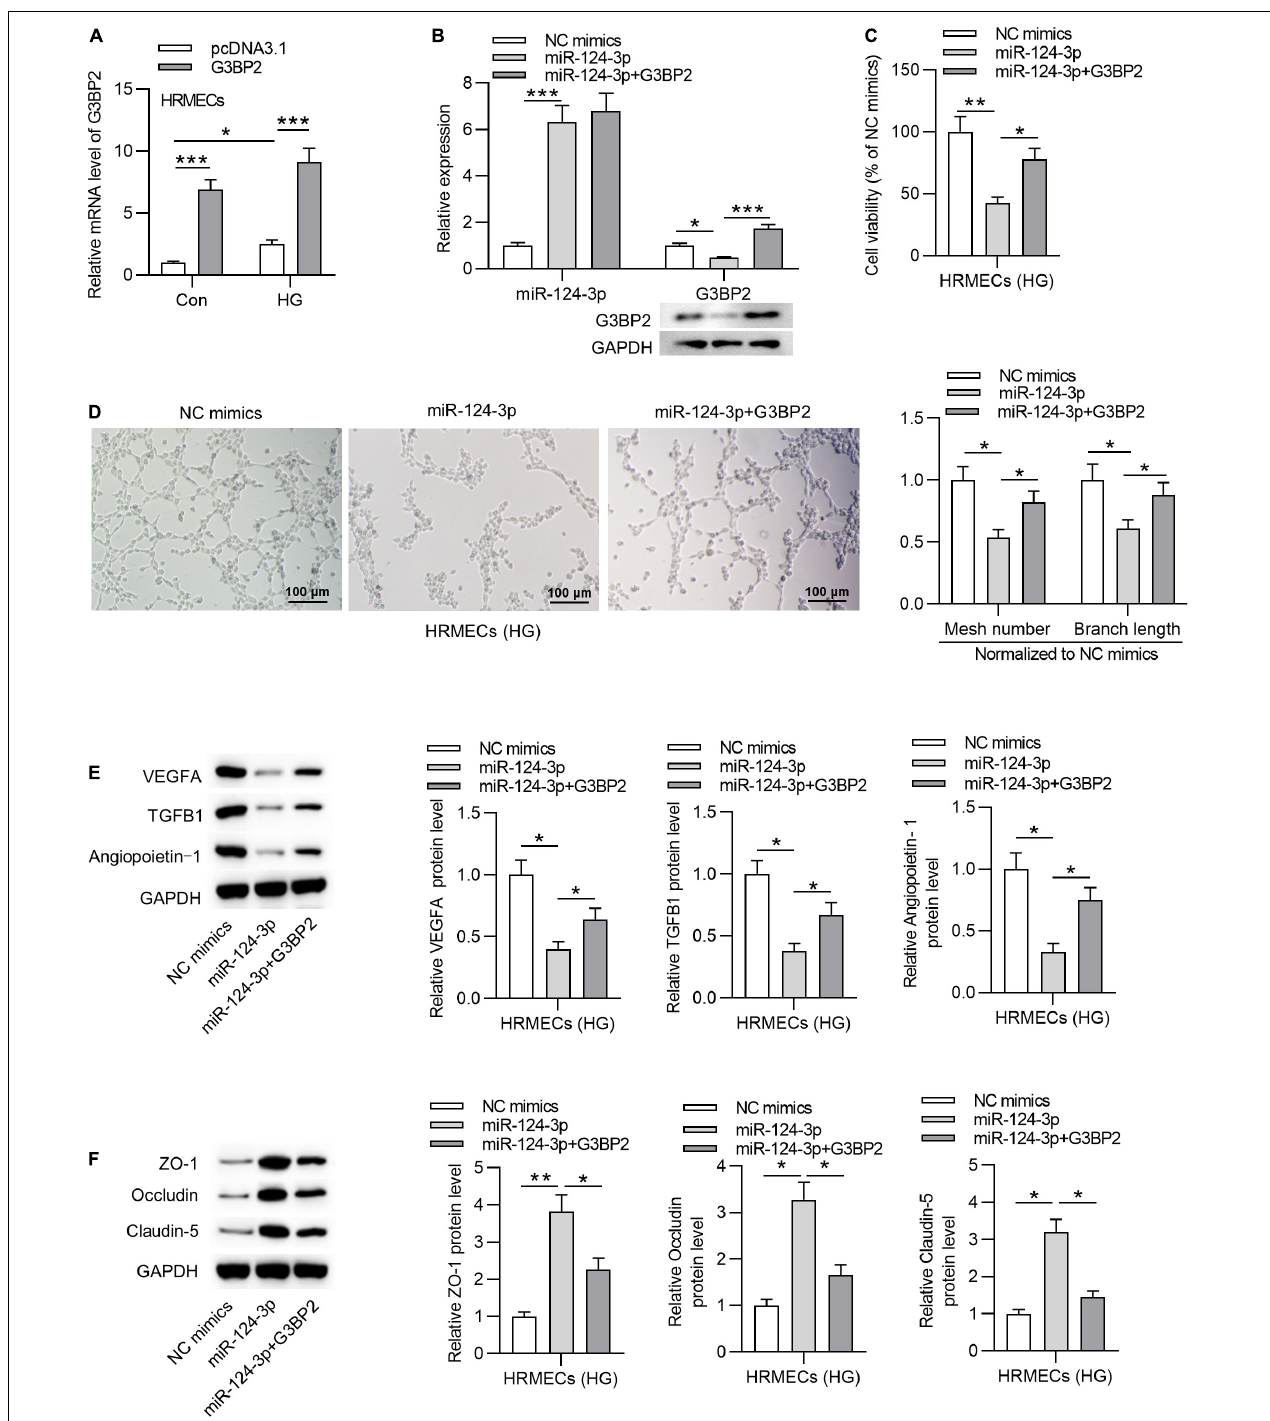
FIGURE 4 | MiR-124-3p suppressed cell injury through G3BP2 in HG-stimulated HRMECs. (A) HRMECs were stimulated with NG (5 mM glucose) or HG (30 mM glucose) for 48 h and transfected with pcDNA3.1-G3BP2 for 24 h. The overexpression efficiency of G3BP2 was assessed by RT-qPCR analysis. (B) Expression of miR-124-3p in HRMECs after transfection of miR-124-3p mimics or co-transfection of miR-124-3p + G3BP2 for 24 h was evaluated by RT-qPCR analysis, while that of G3BP2 was evaluated by RT-qPCR and western blotting. (C) The viability of HG (30 mM glucose)-stimulated HRMECs for 48 h followed by the transfection of miR-124-3p mimics or co-transfection of miR-124-3p + G3BP2 for 24 h was evaluated by CCK-8 assay. (D) The mesh number and branch length of HG (30 mM glucose)-stimulated HRMECs for 48 h after transfection of indicated plasmids for 24 h was revealed by tube formation assay. (E) Western blot analysis measured the levels of proteins associated with angiogenesis (VEGFA, TGFB1 and Angiopoietin-1) in HG (30 mM glucose)-stimulated HRMECs for 48 h followed by transfection of